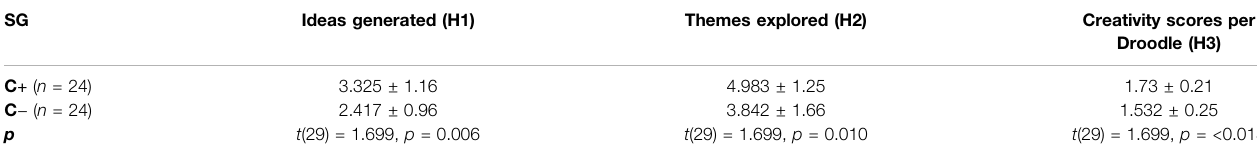
TABLE 2 | Droodle Creativity game t -test results per condition for each study hypothesis.